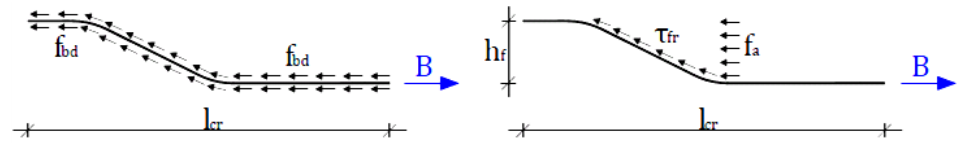
Figure 2. Mechanisms reacting to extraction force B for a fiber embedded in concrete: bond f bd ( left ) and combination of capacity of concrete against compression inside a bent f a and the corresponding friction τ fr ( right